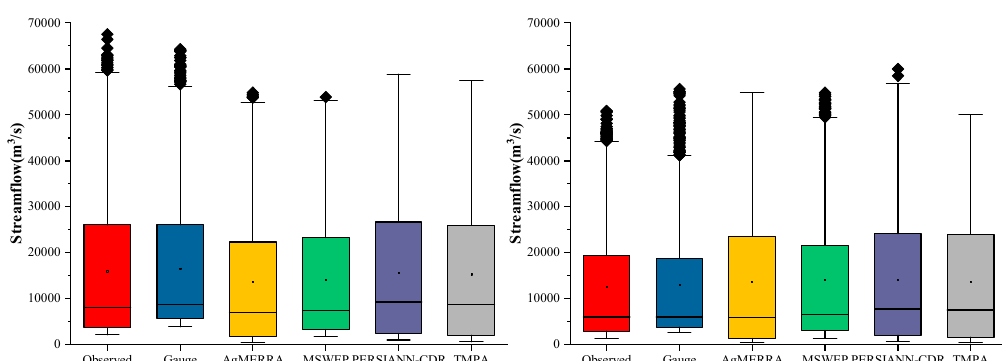
Figure 5. Box plots of observed and simulated streamflow data during the calibration (left panel, 2000 to 2003) and validation (right panel, 2004 to 2007) periods (Notation: The upper and lower bounds are determined by the 75th percentile and 25th percentile; the black dots represent the average of observed or simulated streamflow; the outliers represent large streamflow values observed or simulated; and the horizontal lines inside the box represent the median of the variable).